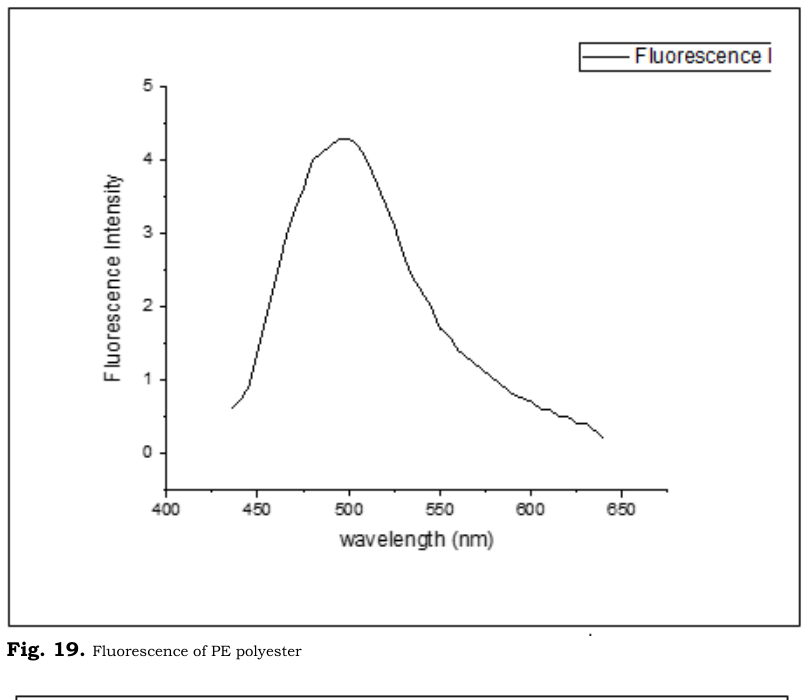
Fig. 19. Fluorescence of PE polyester